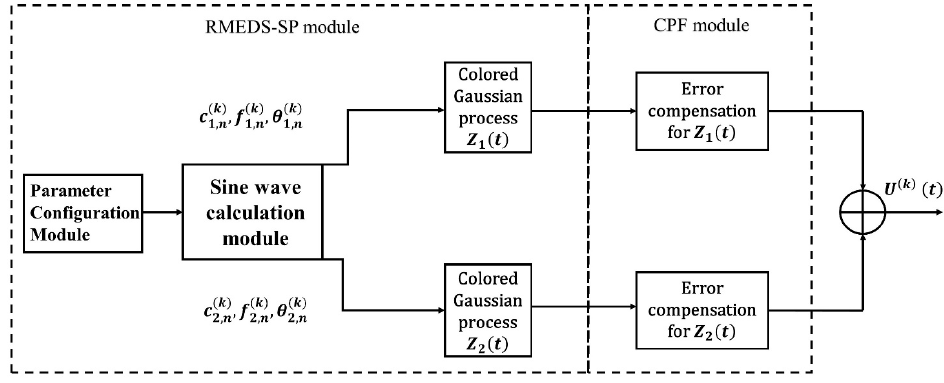
Figure 14. Hardware implementation of RMEDS-SP model.